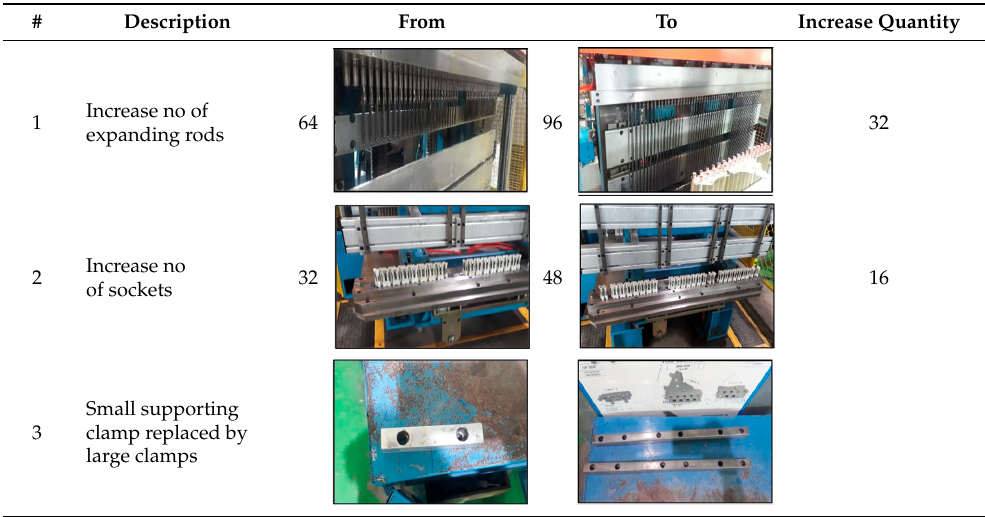
Table 7. Modifications in expanding machine.